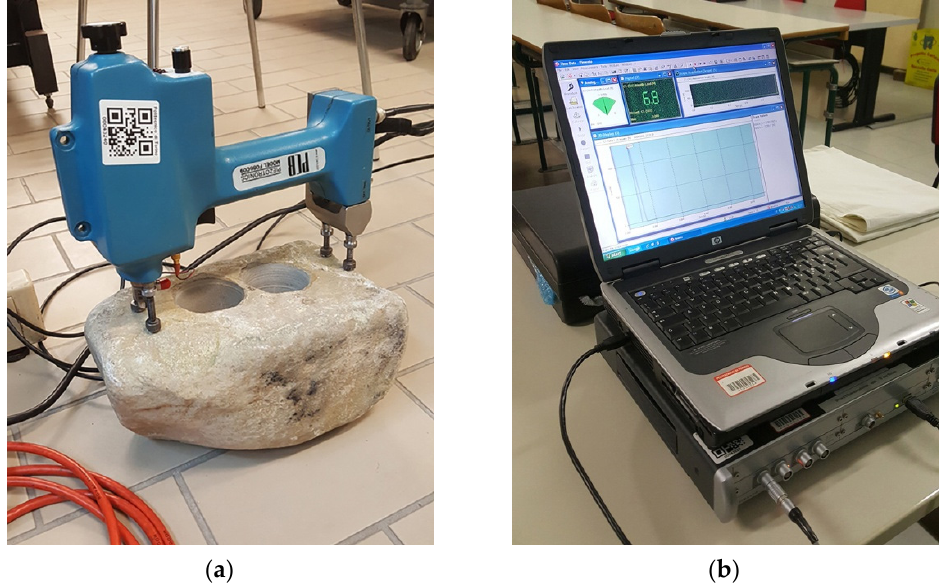
Figure 5. ( a ) Electric impact hammer; ( b ) Pimento model multichannel LMS signal analyzer.